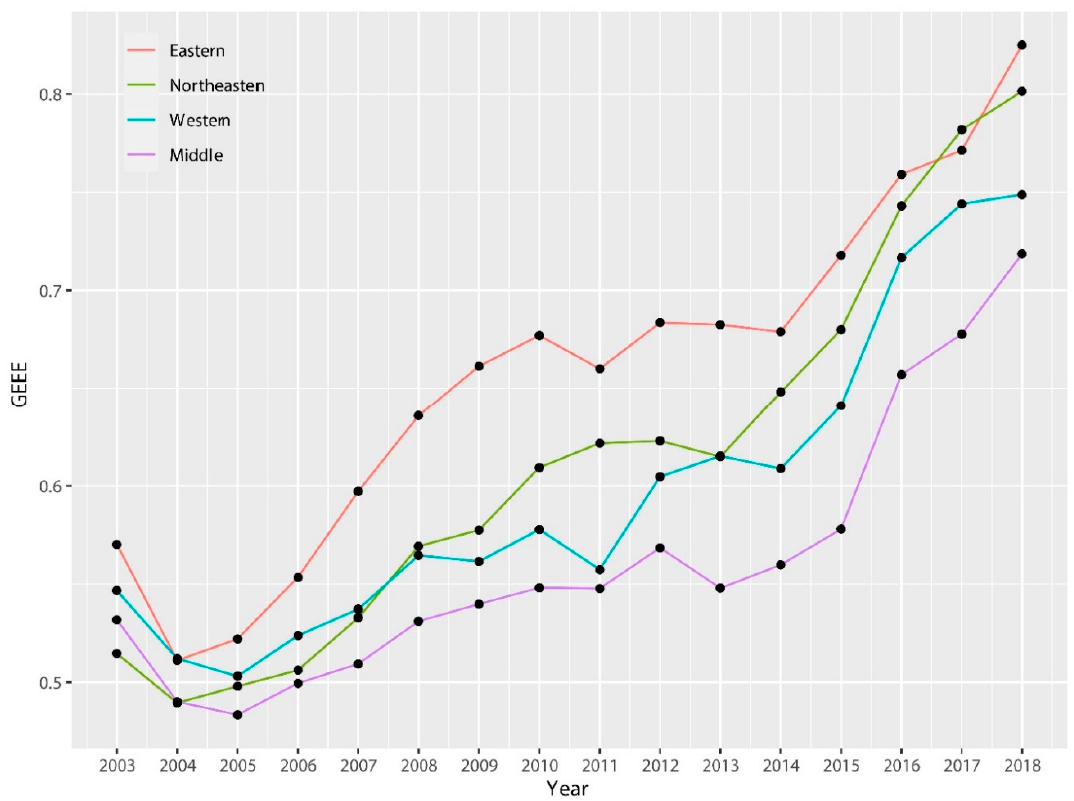
Figure 5. Trend of GEEE for classification by region from 2003 to 2018.